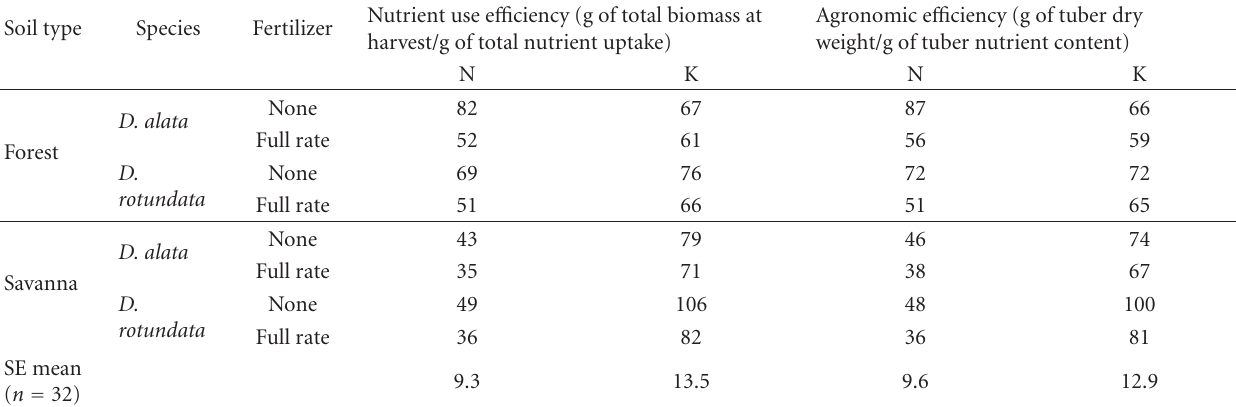
Table 4: Nitrogen and potassium use e ffi ciency and agronomic use e ffi ciency of Dioscorea spp. as a ff ected by soil type and fertilizers. Soil